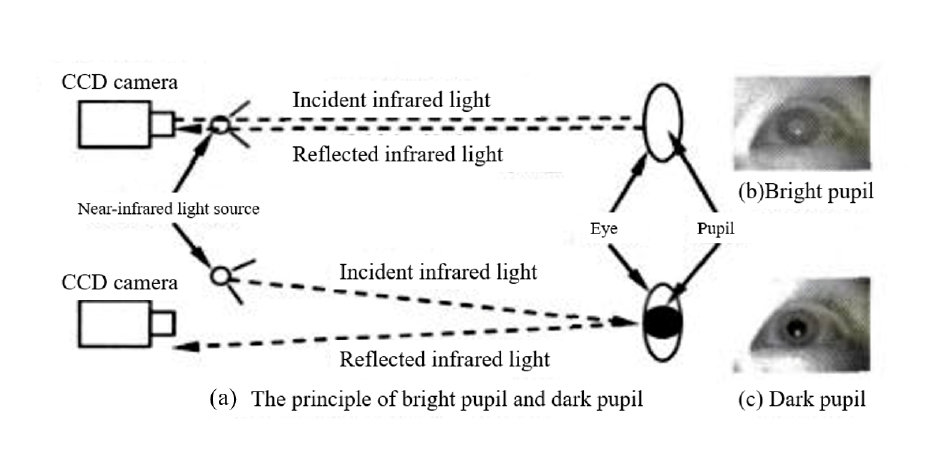
Figure 1. Pupil formation principle of light pupil and dark pupil